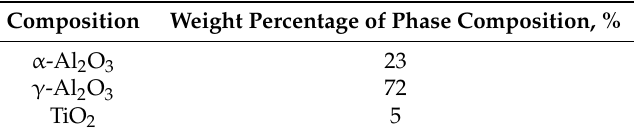
Table 4. Detailed results of XRD.